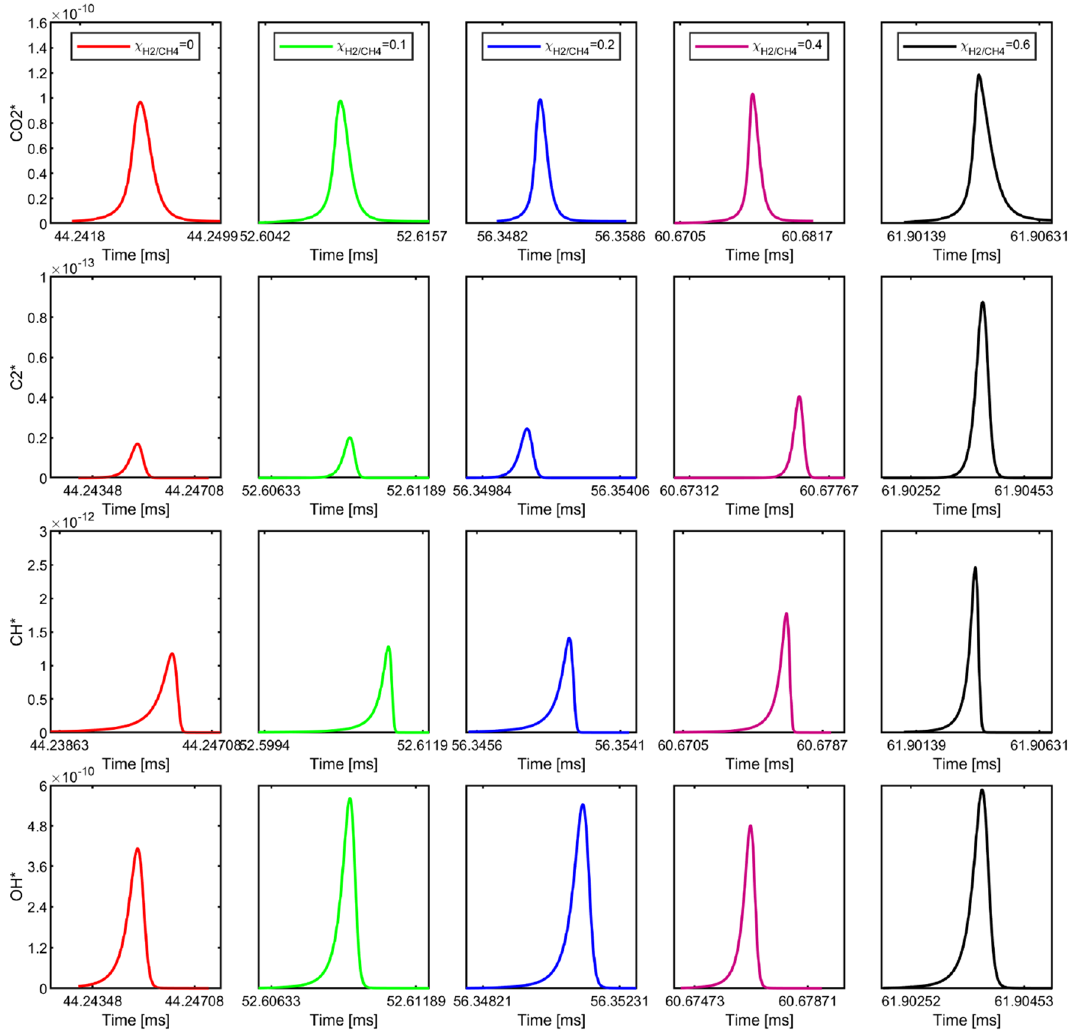
Figure 12. The excited species concentration profiles of CH 4 /H 2 /Air mixture combustion at different χ H 2 / CH 4